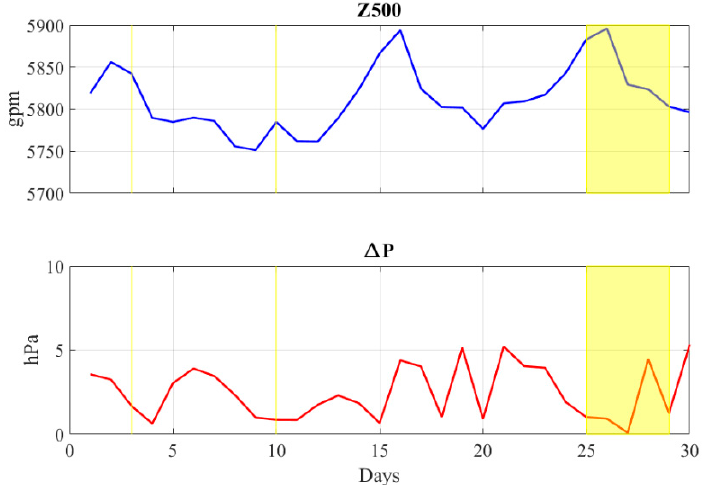
Figure 6. Daily 500 hPa geopotential height (blue line) and sea-level pressure gradient (red line) observed in the study area during 1–30 September period. Both fields, expressed in gpm and hPa, respectively, have been retrieved from ERA5 reanalysis. The yellow-shaded regions indicate the periods in which at least one of the reference air quality stations recorded an exceedance of daily PM 10 levels.